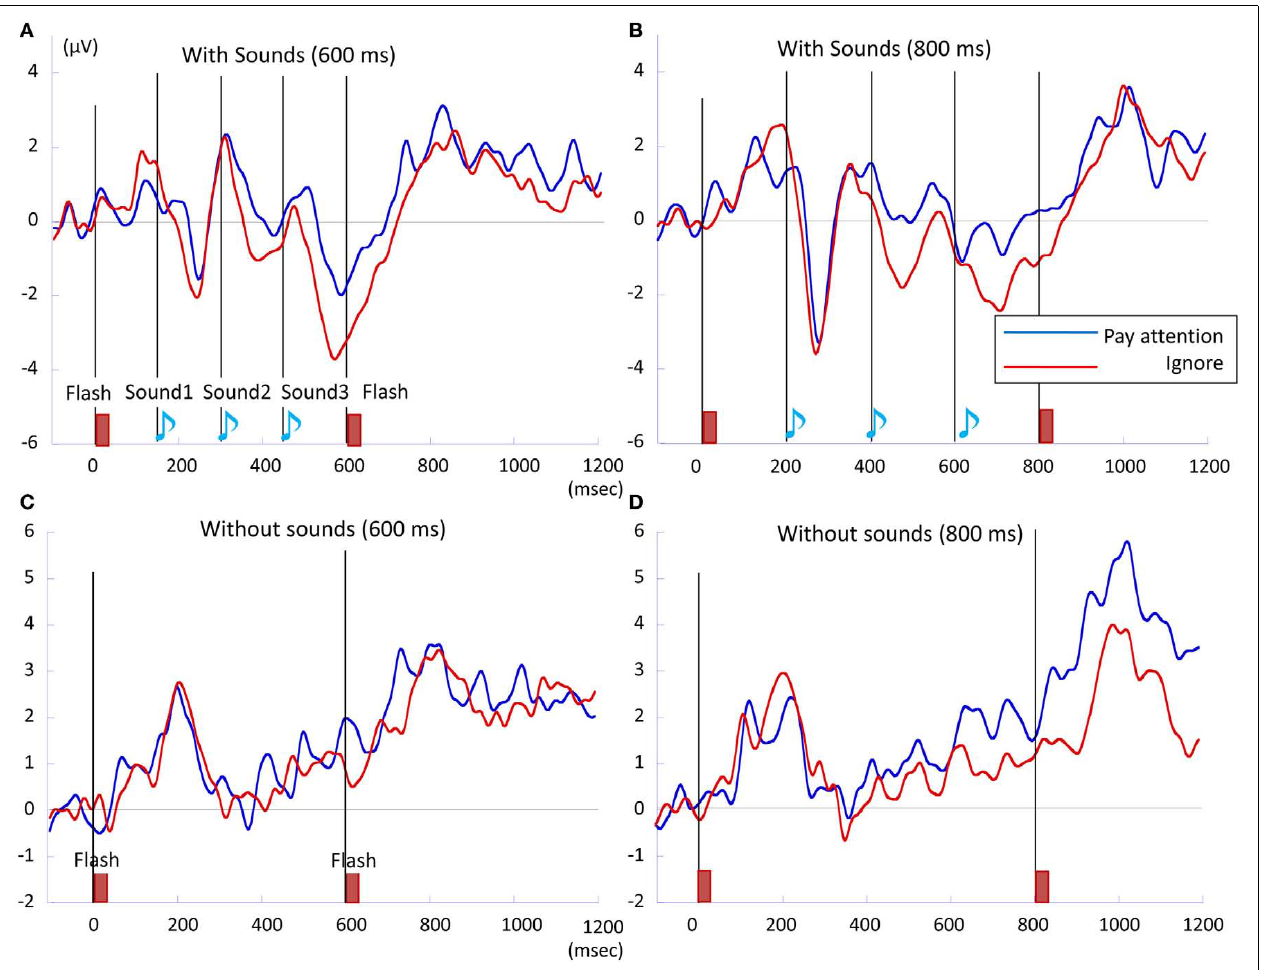
FIGURE 6 |The P300 waveforms of (A) 600ms with-sounds, (B) 800ms with-sounds, (C) 600ms without-sounds, and (D) 800ms without-sounds condition. The integrated P300 amplitude was calculated over successive